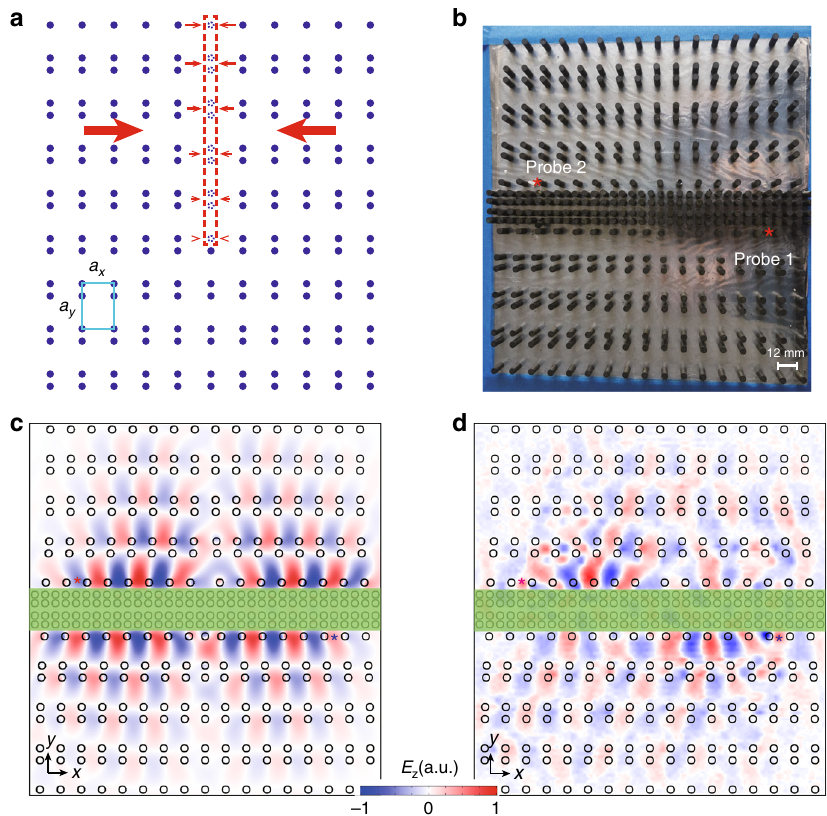
Fig. 3 Dislocation in the topological photonic crystal. a Forming the dislocation. A half column of unit cells in the red-dashed region is taken away. The rest of the photonic crystal is compressed toward the red-dashed region to restore the lattice order except at the dislocation. b Experimental sample with a dislocation of Burgers vector B = ( a x , 0) and an inserted chunk of topologically trivial photonic crystal. c Con fi rmation of the π phase elapse of the relative phase between the opposite edge channels in the presence of the dislocation from simulation. d Field distribution measured in the two-points pumping